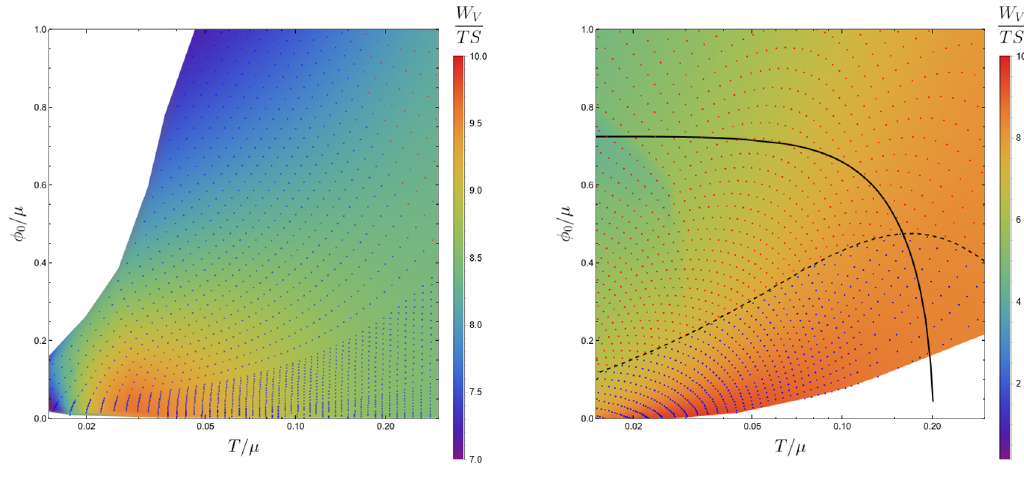
Figure 12 . Asymptotic volume complexity rate W V , as defined in eq. (3.22), in units of TS . Left: neutral scalar case ( q = 0 ). Blue ploints denote type U solutions, red points denote type D solutions. Right: charged scalar case with q = 1 . Blue points denote type U solutions, yellow points denote type D solutions. In both cases, there is no direct correlation between the complexity rate and the coefficient p t plotted in figures 4 and 10. The white region of the plots is not covered by our numerics.